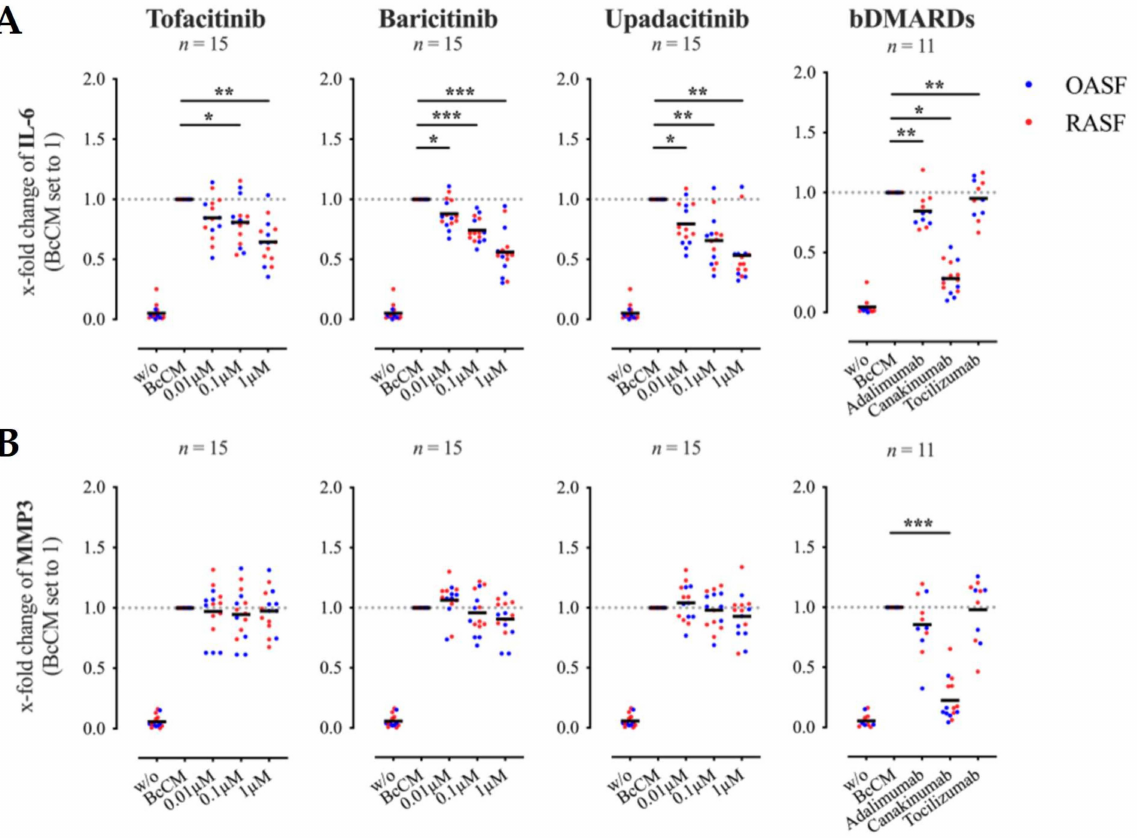
Figure 5. Effects of tofacitinib, baricitinib, upadacitinib and bDMARDs on IL-6 ( A ) and MMP3 ( B ) secretion by SF stimulated with B cell-conditioned culture media (BcCM). B cells were stimulated with staphylococcus aureus Cowan I (SAC) plus IL-2 and supernatant (BcCM) was collected on day 3. OASF (blue) and RASF (red) were cultured with or without BcCM and drugs as indicated for 5 days. Supernatant was collected and cytokines quantified by ELISA. Results are presented as x-fold change with SF stimulated with BcCM set to 1 (mean concentrations ± SEM in ng/mL: IL-6: 215.21 ± 42.02; MMP3: 244.95 ± 49.37). bDMARDs shown were used at a concentration of 100 µ g/mL. Data shown as grand mean, significance tested using Wilcoxon signed-rank test, p *** ≤ 0.001, p ** ≤ 0.01, p * ≤